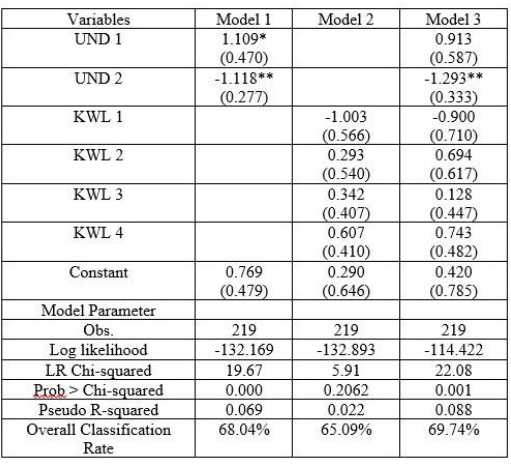
Table 1: Logit Regression for Understanding and Knowledge of Capital